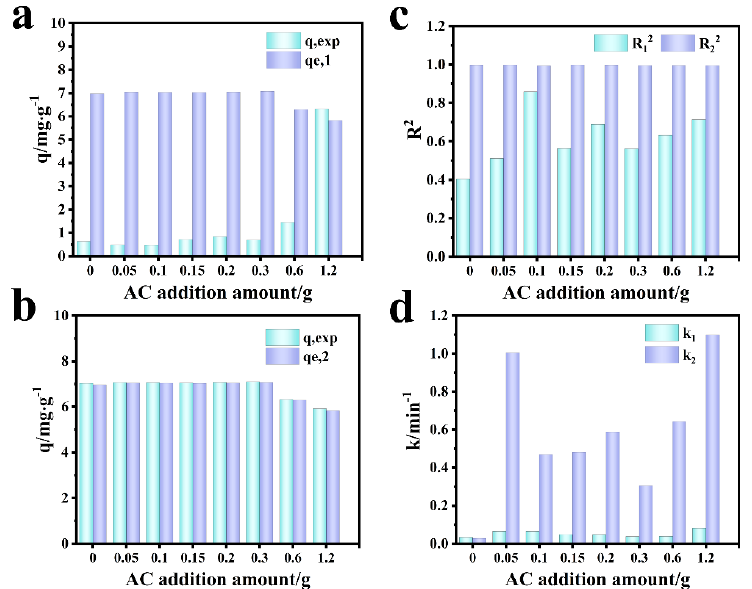
Figure 10. Comparison of simulation results of Cr (VI) adsorption kinetics by composite membrane. ( a ) First-order dynamics q e,1 vs. q exp . ( b ) Second-order dynamics q e,2 vs. q exp . ( c ) R 12 vs. R 22 ; ( d ) k 1 vs. k 2